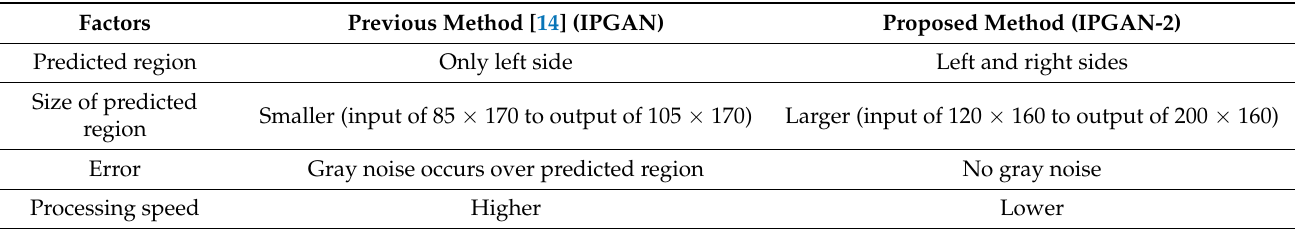
Table 10. Comparison of advantage and disadvantage of previous method [14] and proposed